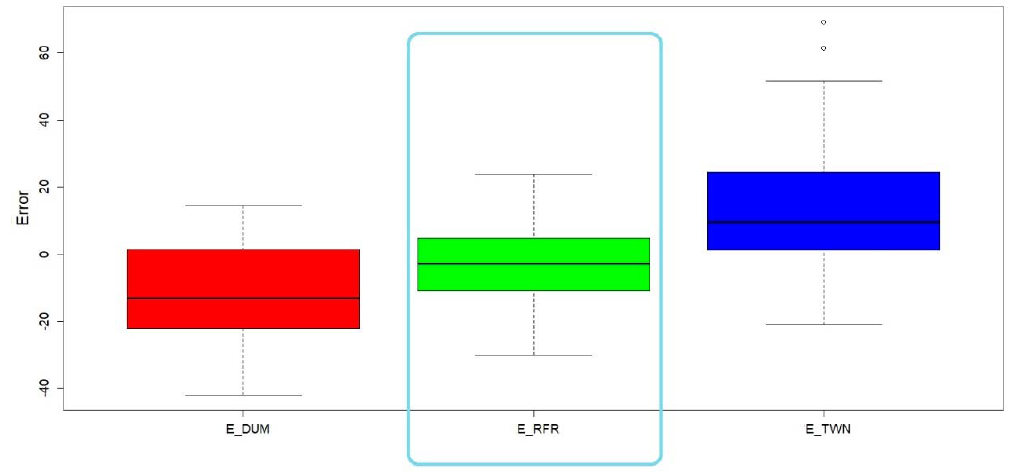
Figure 7. Distribution of the residuals (net errors) for the dummy, RFR, and TWN prediction methods.